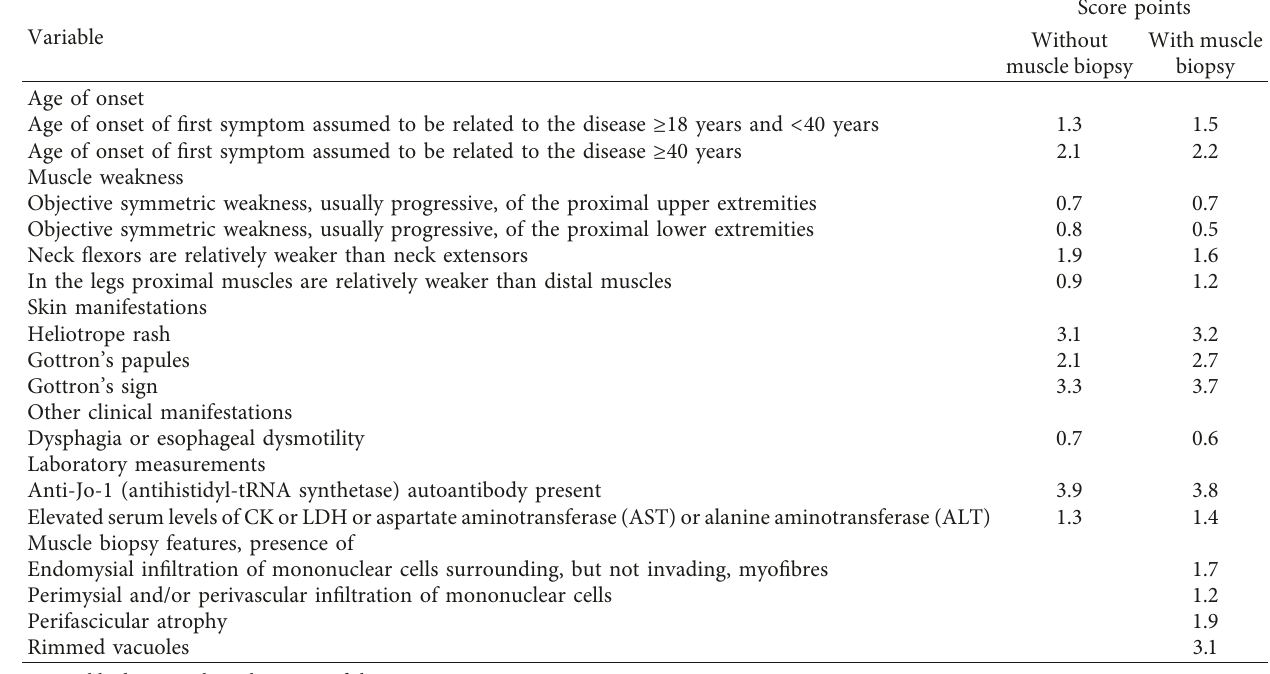
Table 1: The EULAR/ACR classification criteria for adult and juvenile idiopathic inflammatory myopathies 4.